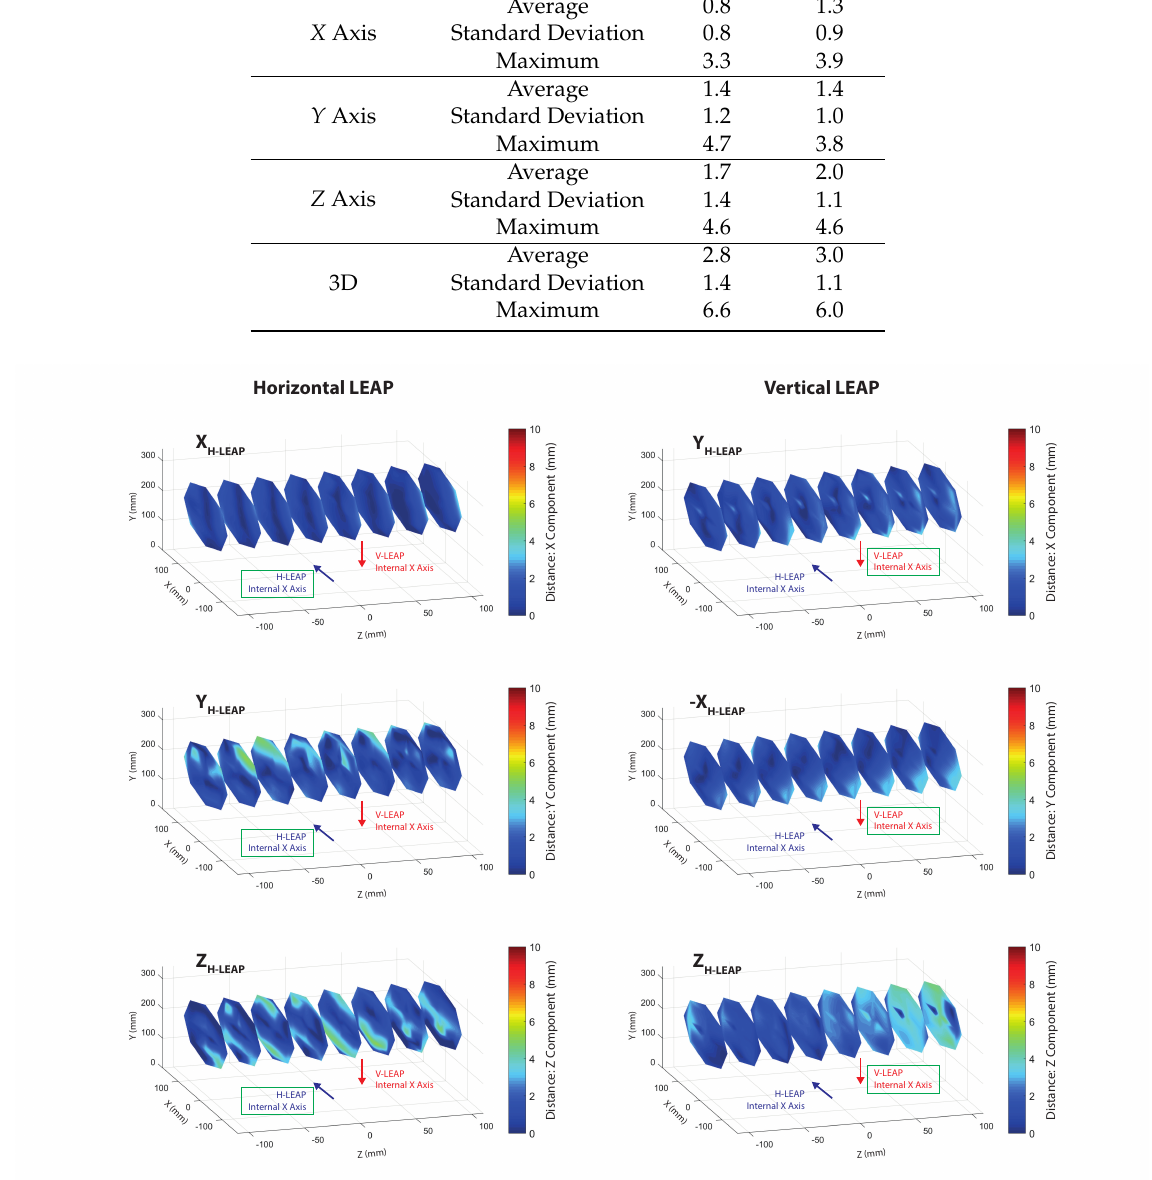
Figure 5. Distance between points measured by the mill positioning system and by each of the LEAPs along different axes after calibration. Since measurements were referred to the mill axes, the original LEAP axes were reported inside the graphs to allow a direct comparison between corresponding axes of both sensors. The position of the internal x axis of each LEAP was also reported. The green box indicated the “active”